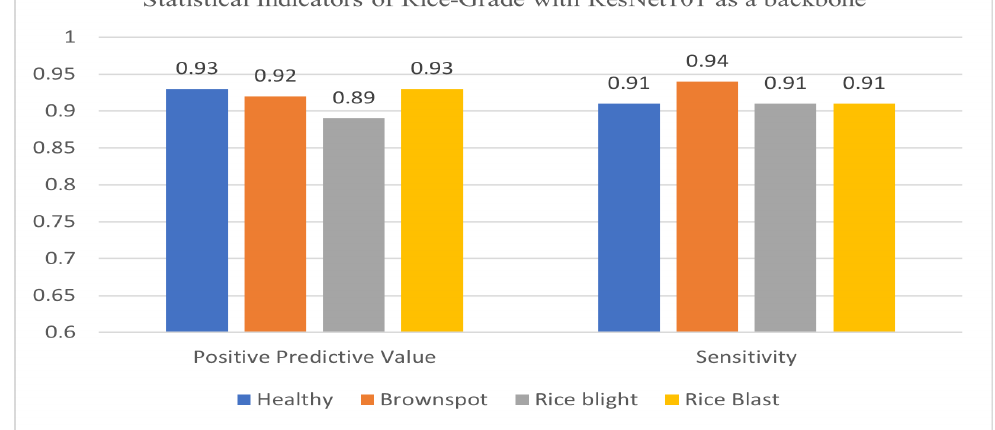
Figure 8. PPV, sensitivity, and DSC of proposed model using ResNet101 backbone